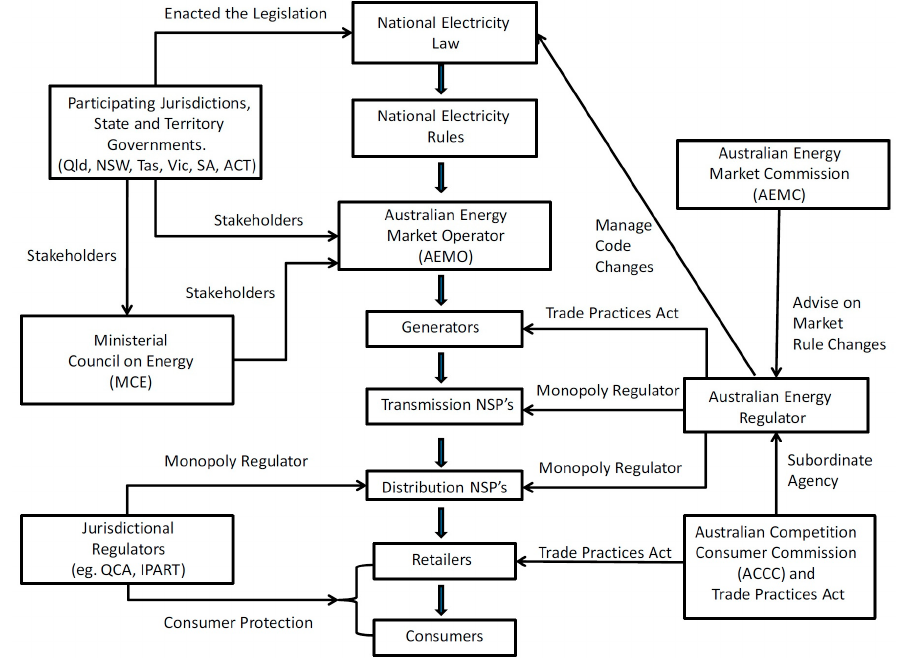
Figure 9. Net energy metering (NEM) regulatory environment [81].